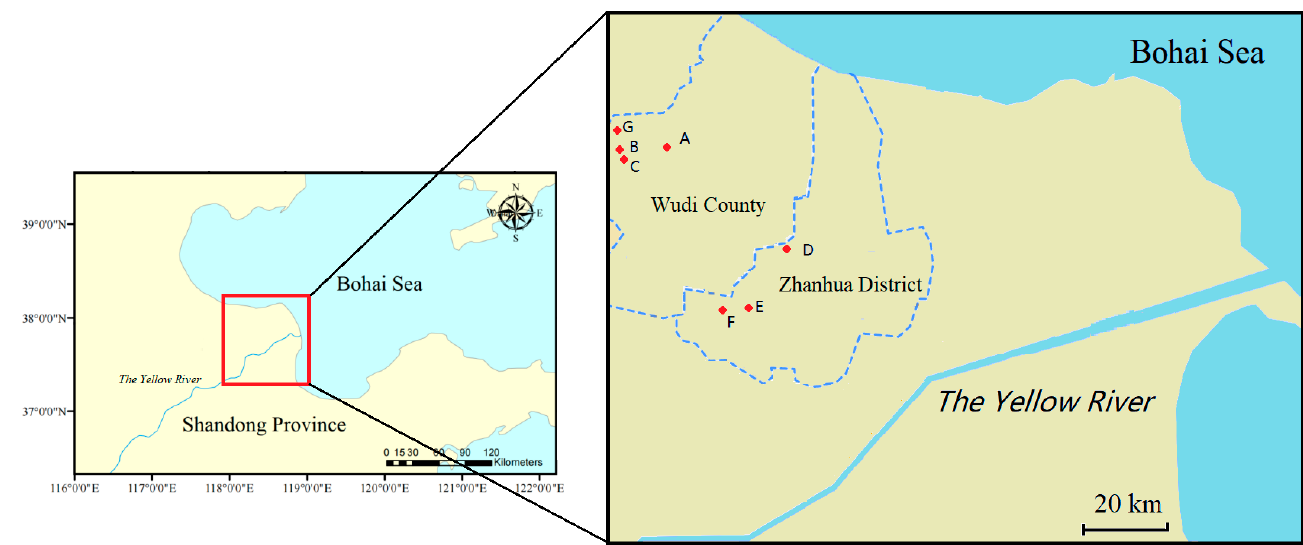
Figure 1. Location map of the sampling area (A: S1–S2; B: S3–S4, C: S5–S6; D: S7–S8; E: S9–S10; F: S11–S13; G: S14. A–E representing different villages).